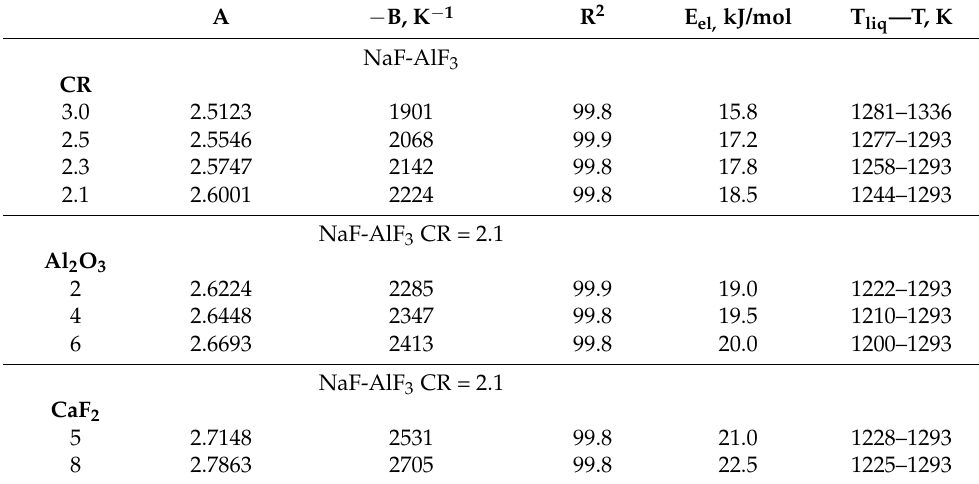
Table 1. Coefficients A and B for ln κ = A + B/T and the activation energy of the electrical conductivity of cryolite